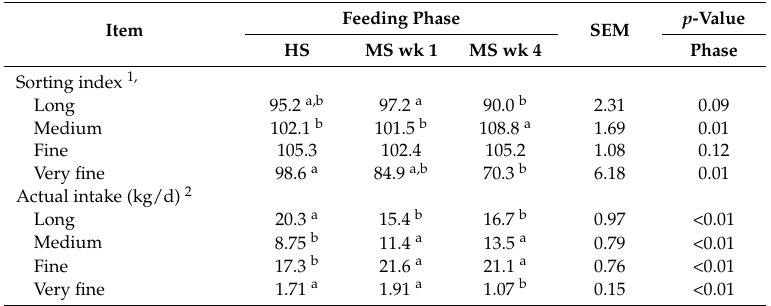
Table 4. Effects of the feeding phase on sorting behaviour of long, medium, short, and fine particles 1 in cows fed either a diet with 40% concentrate content high in physical structure (24.4% peNDF > 8 mm DM basis; HS), or a 60% concentrate diet with moderate physical structure content (17.6% peNDF > 8 mm; MS). Samples were taken during HS, MS wk 1 and during MS wk